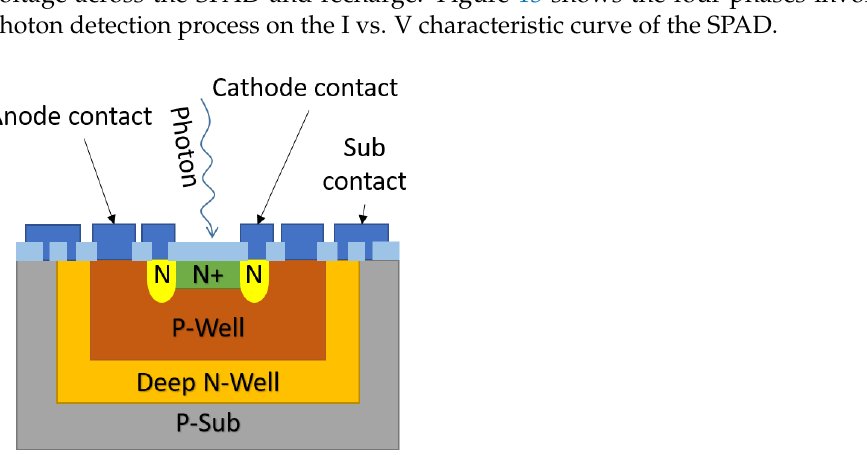
Figure 12. The junction scheme of a single photon avalanche photodiode (SPAD) device.